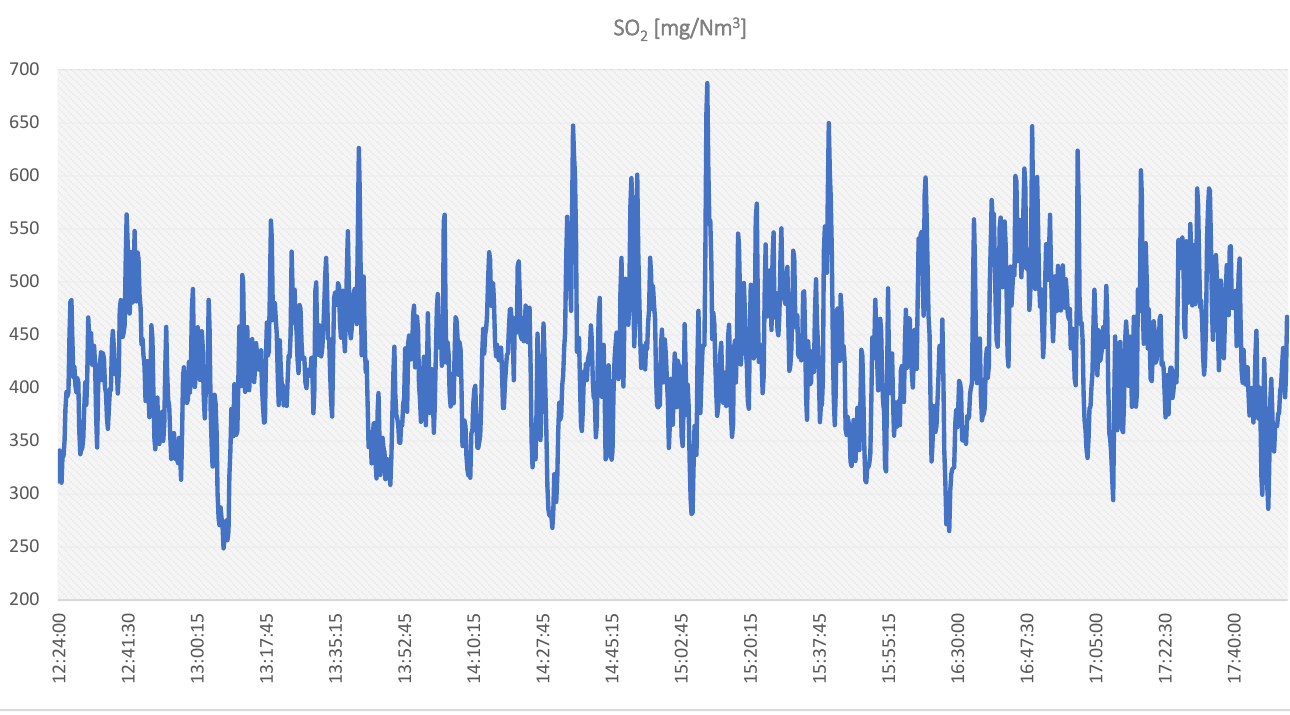
Figure 5. SO 2 emission trend during combustion test.